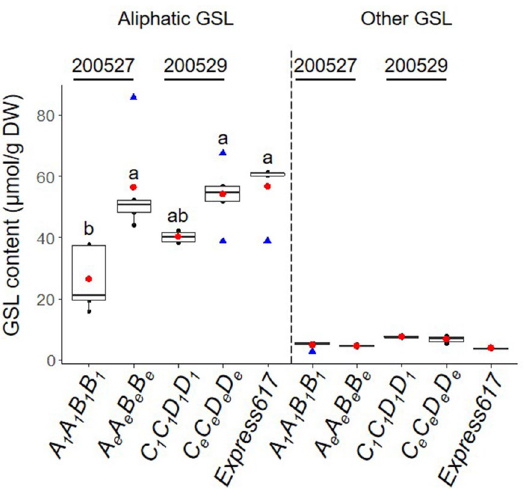
Figure 4. Analysis of major glucosinolate types in mature seeds of BnMYB28 and BnCYP79F1 mutants. Aliphatic and other GSL types measured from homozygous BnMYB28 (genotype A 1 A 1 B 1 B 1 , seed